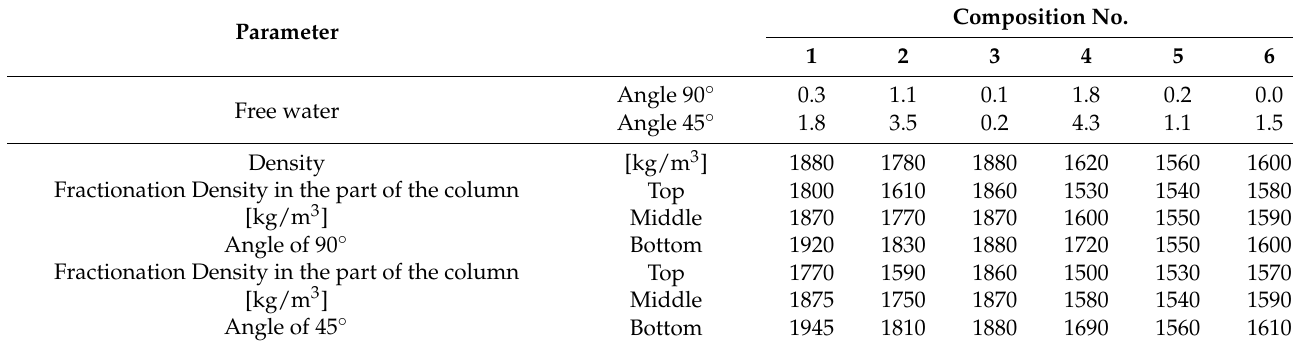
Table 3. Selected parameters of cement slurries based on class A